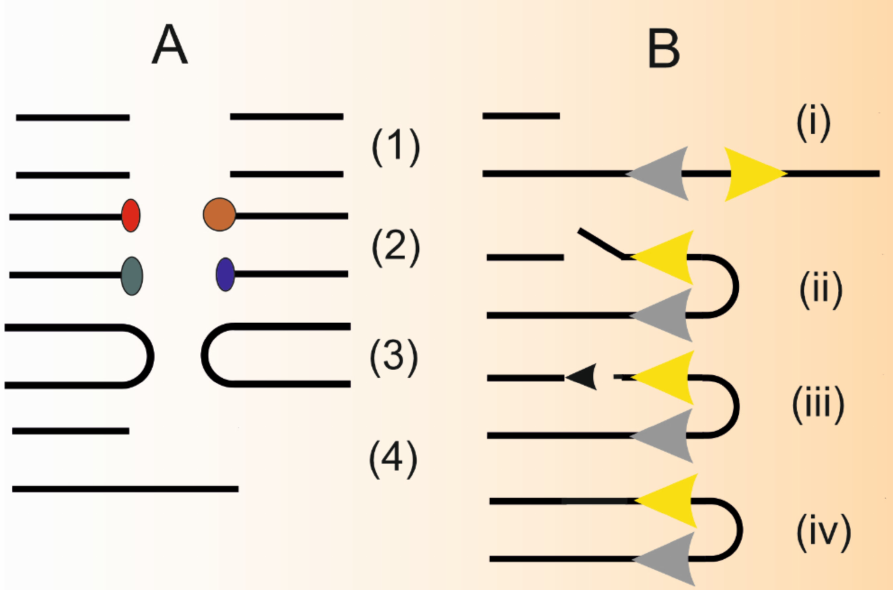
Figure 3. Different structures of DNA double-strand breaks (DSBs) ( A ): “clean” termini (3 (cid:48) -OH or 5-P) (1), termini blocked by different (color and shape) chemical groups (2), hairpin-structured ends (3) and one-ended DSB (4). Single-strand annealing (SSA) in one-ended DSB with inverted homologous repeats ( B ). Grey and yellow arrows depict homologous, but not necessarily identical sequence oriented in opposite directions (i) that are annealed and protruding non-homologous 3 (cid:48) ends are removed by an endonucleolytic cleavage (ii); remaining gap is fulfilled by a DNA polymerase (black arrow) (iii) and lacking phosphodiester bond is sealed by DNA ligase